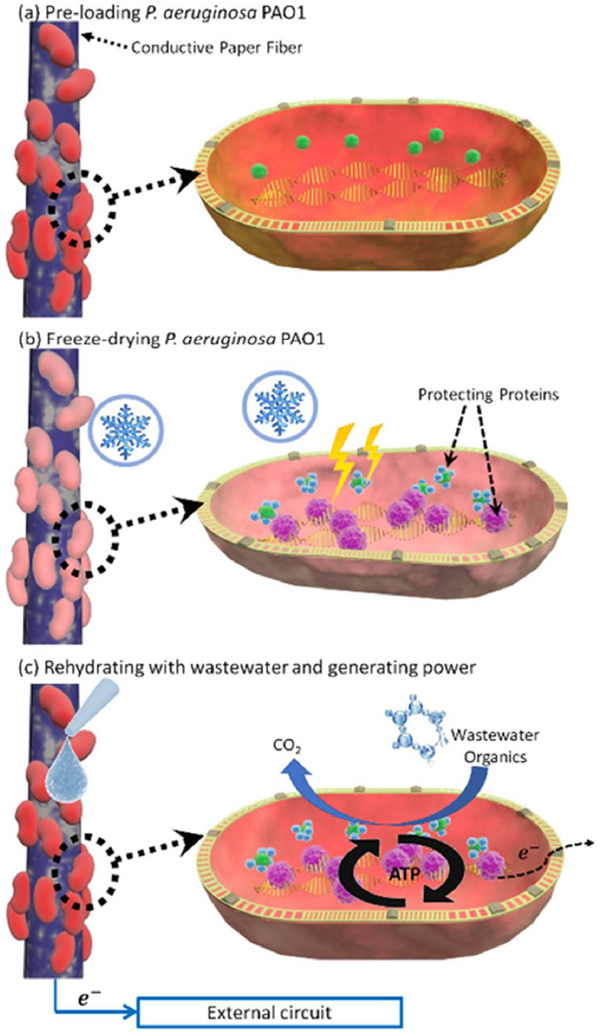
Figure 5. Schematic illustration of bacteria storage, their rehydration with wastewater, and their power generation. ( a ) Pre-loading bacterial cells in the anodic reservoir, ( b ) freeze-drying the device with the cells, and ( c ) rehydrating the cells for on-demand power generation.